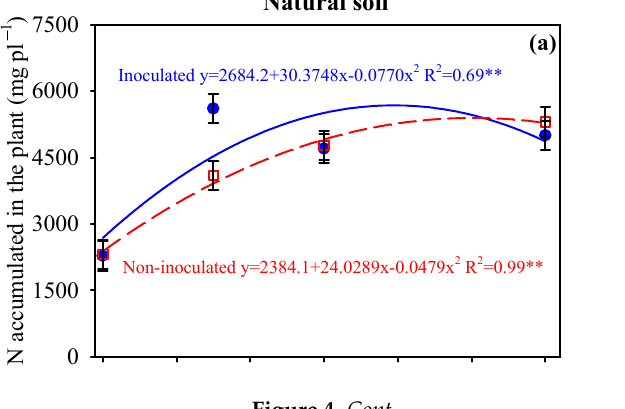
Figure 4. Amount of N accumulated in the whole plant ( a , b ), N-uptake efficiency ( c , d ), and N-use efficiency ( e , f ) of potato in response to N application rates and A. brasilense inoculation in natural and disinfected soil. Bars represent the least significant difference between A. brasilense inoculation in the same N rate at p < 0.05 according to the LSD test. ** p < 0.01. The amount of N accumulated in the cassava plants in the natural soil increased sig- nificantly up to 50 mg dm − 3 N in the inoculated plants, and up to 152 mg dm − 3 N in the non-inoculated plants (Figure 5a). At a rate of 50 mg dm − 3 N, the inoculated cassava plants accumulated 19% more N than the non-inoculated plants. In disinfected soil, the amount of N accumulated by cassava plants increased linearly with N fertilization in the non- inoculated plants, and up to an estimated rate of 163 mg dm − 3 N in the inoculated plants